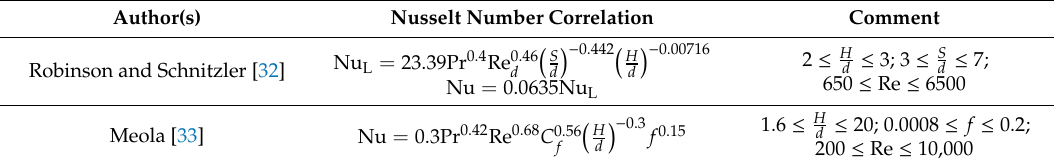
Figure 6. The Nusselt number predictions versus the authors’ own experimental data (heating side). Table 4. The Nusselt number correlations selected for the comparison.